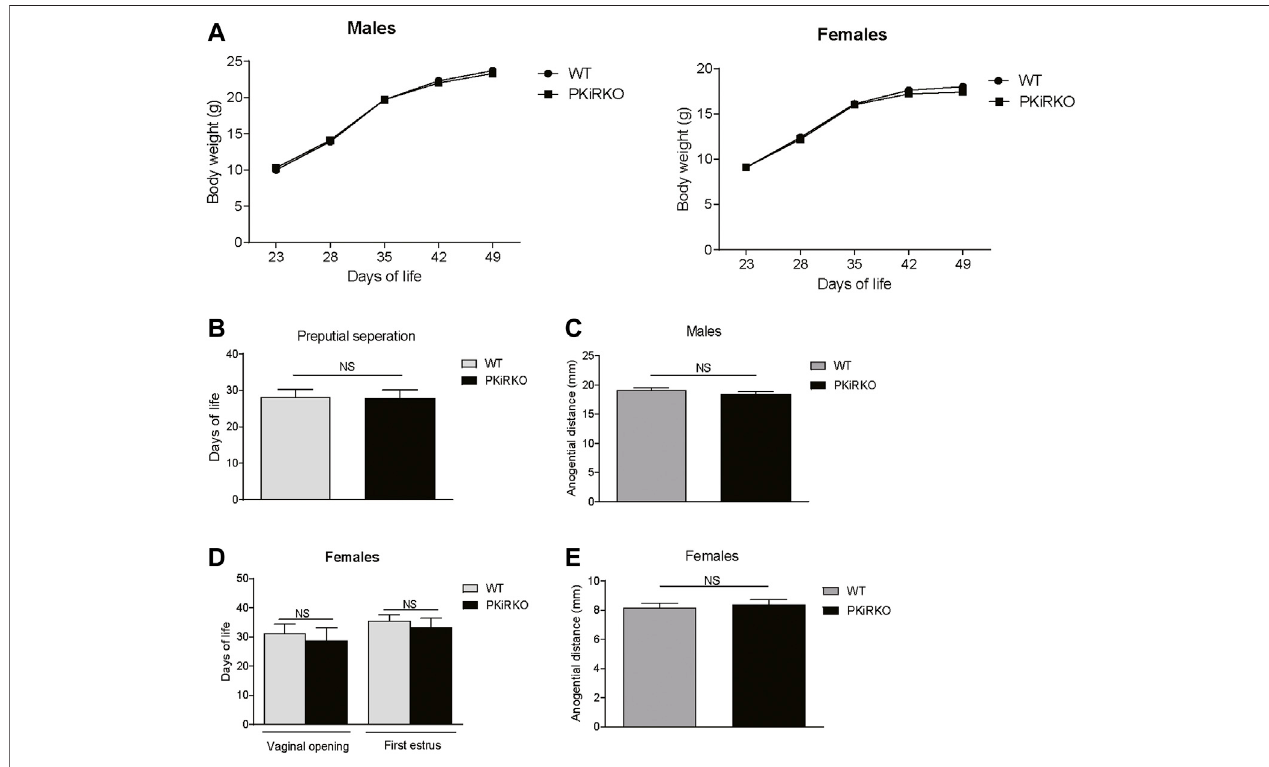
FIGURE2| PKiIRKO micehavenormalpuberty onset. (A) BodyweightchangeovertimewasnotdifferentbetweenPKiRKO ( n =15)andWT( n =15)malemice or femalePKiRKO( n = 15) and WT ( n = 15) mice. (B) Nosigni fi cant difference wasobserved in age ofpreputialseparation (PPS) inmales. WT ( n = 15) PKiRKO ( n =15). (C) AnogenitaldistancewasnotdifferentbetweenWTandPKiRKOmalemice( n =6eachgroup). (D) Nodifferencewasobservedinageatvaginalopeningor fi rstestrus. (E) Anogenital distance was not different between WT and PKiRKO female